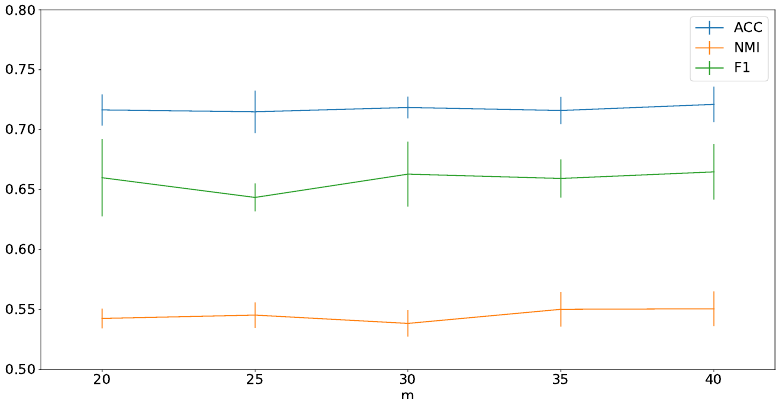
Figure 3. The influence of parameters on the results of the Cora dataset in GLGC.